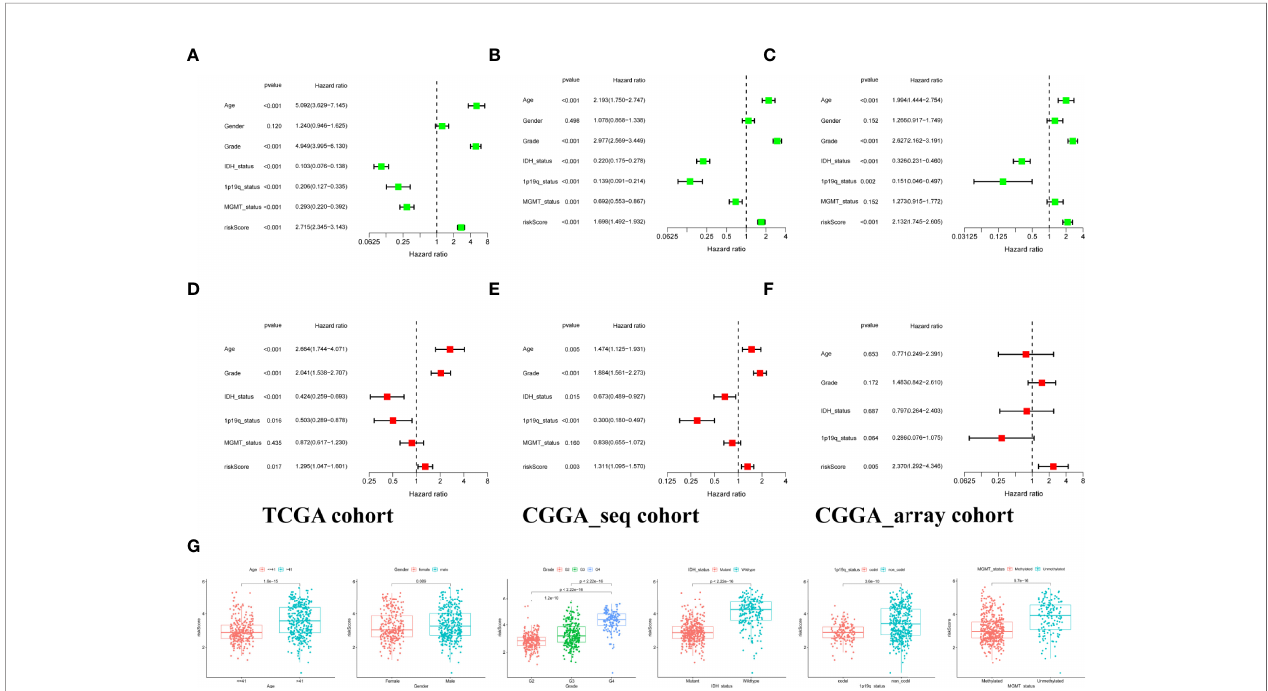
FIGURE 2 | Independent prognostic analysis of risk signature. (A – C) Identi fi cation of the prognostic values of clinical characteristics and risk signature via univariate cox regression analysis. (D – F) . A comprehensive evaluation of independent prognostic value after offsetting the effects of other factors by multivariate Cox regression analysis. (G) Strati fi ed analysis of risk scores with various clinicopathological parameters in the training